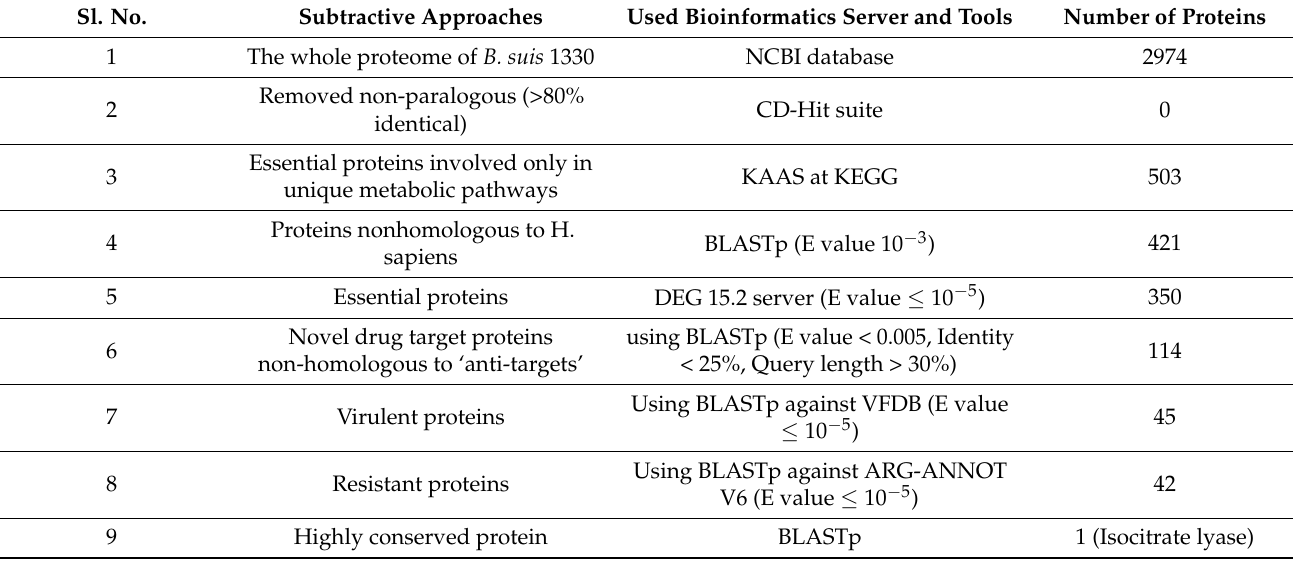
Table 1. Subtractive genomic analysis scheme toward the identification of novel therapeutic targets against B. suis